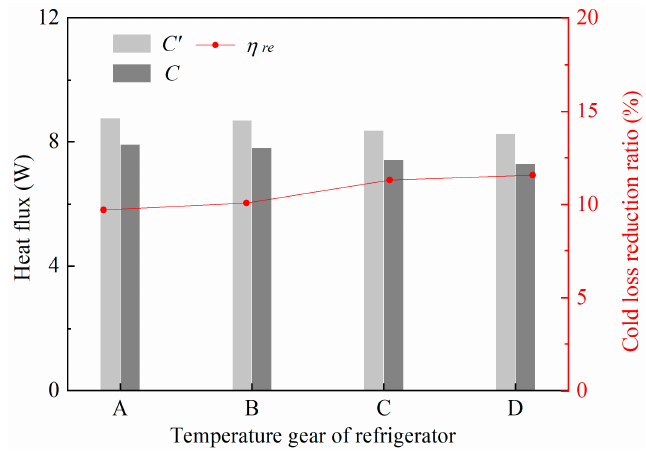
Figure 11. Cold loss recovery behaviors of the improved refrigerator for different temperature gears.